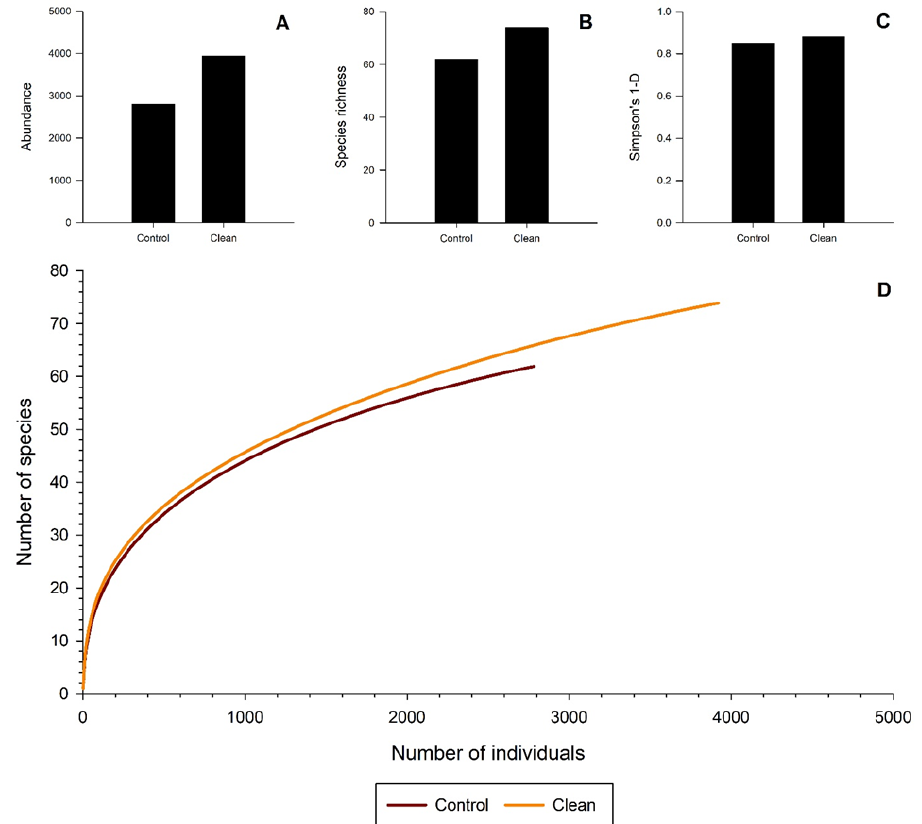
Figure 4. Abundance and diversity metrics for beetles captured in clean vs. control modified multiple-funnel traps during Experiment 2 in southern Maine. ( A ) Abundance of bark and woodboring beetles captured; ( B ) Species richness; ( C ) Simpson’s 1-D estimates; ( D ) Individual-based rarefaction curves. Table 2. Mean ( ± SE) total beetles, species richness, total bark beetles, total cerambycids, and individual species that accounted for ≥ 1% of total beetles captured in trap treatments during Experiment